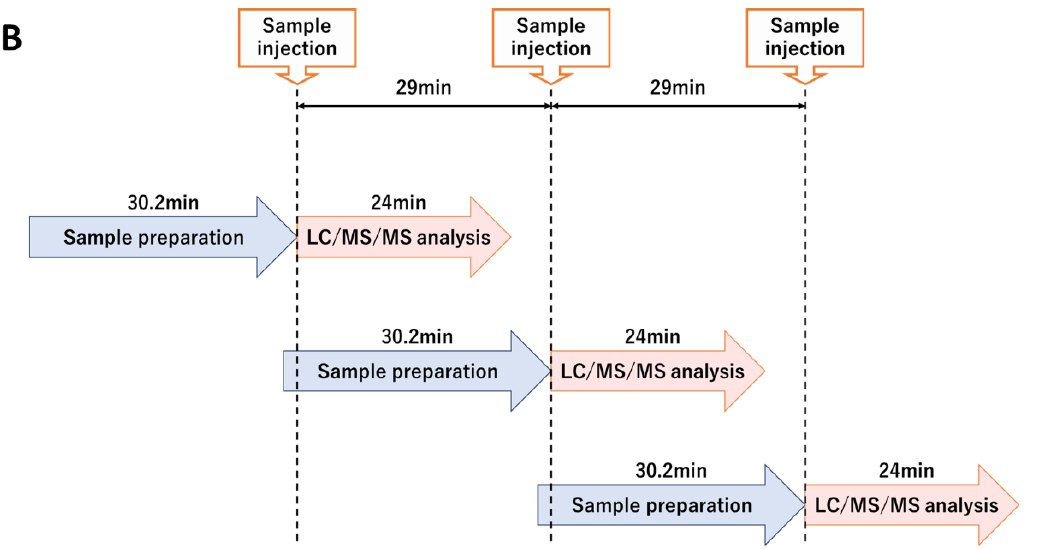
Figure 3. Fully automated organic acid analysis system. ( A ) Schema of the analysis system. ( B ) Flow of sample measurement. The next sample pretreatment can be performed during LCMS analysis.